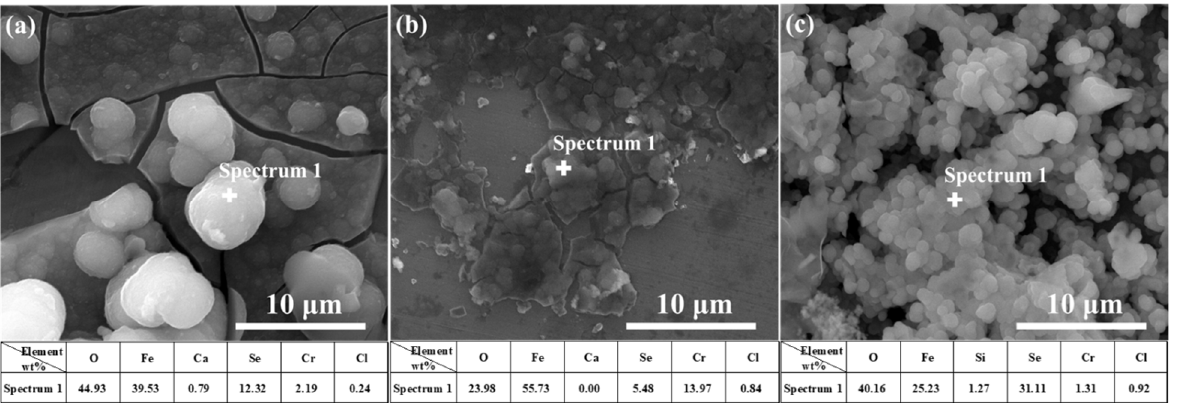
Figure 8. The EDS analysis of 304 stainless-steel samples after being treated by polarization measurements in different solutions and a 4 week immersion test in SG + Na 2 SeO 3 solution: ( a ) SG + CaCl 2 solution; ( b ) SG + Na 2 CO 3 solution; ( c ) SG + Na 2 SiO 3 solution.